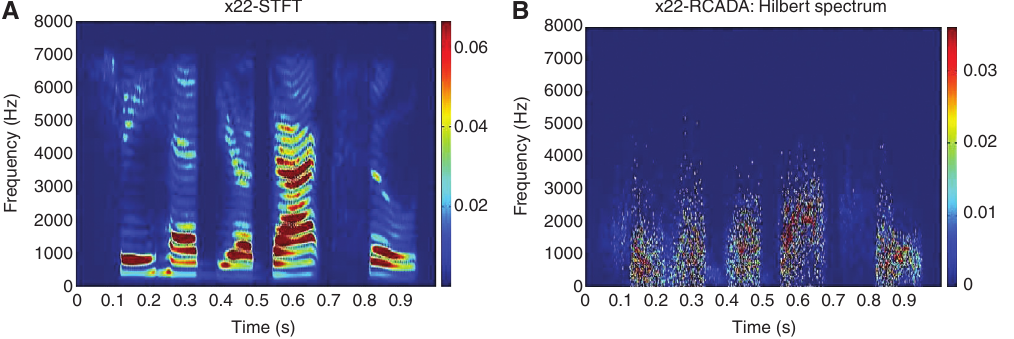
Figure 2. (A) STFT Spectrum and (B) HHT Spectrum for the Male Speech Utterance “ She Had Your Dark Suit ” Chosen from the TIMIT